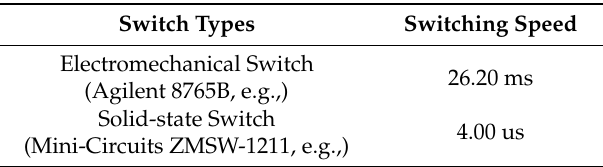
Table 1. The statistics of the measurement result.